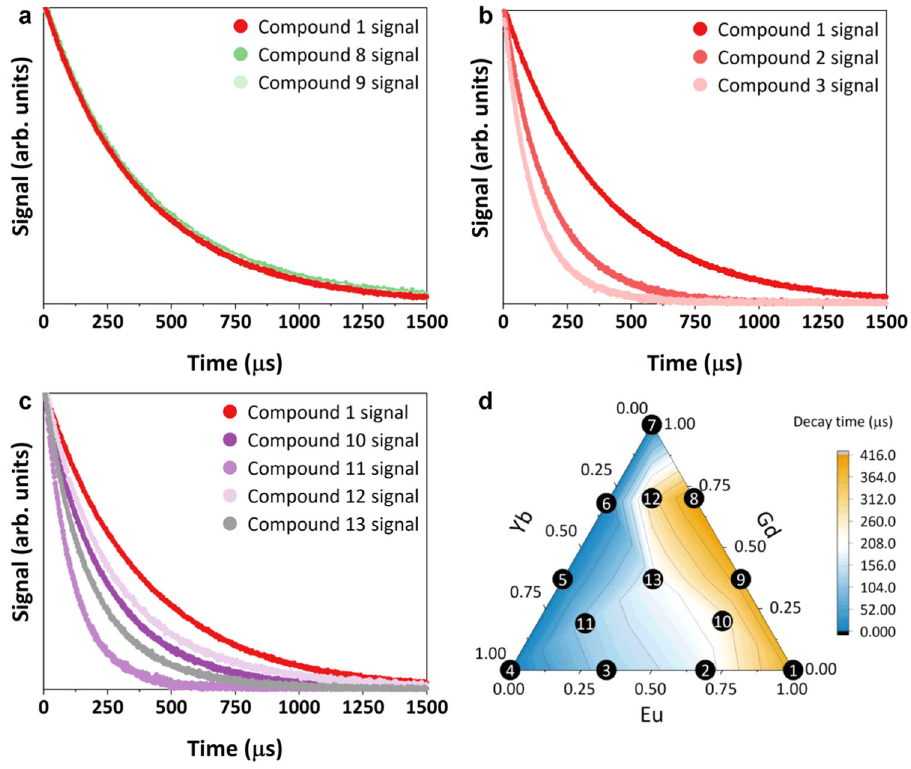
Fig. 4 | Fluorescence decay data for reported compounds. a – c Visible decay curves for all compounds containing Eu; d A ternary diagram of the different